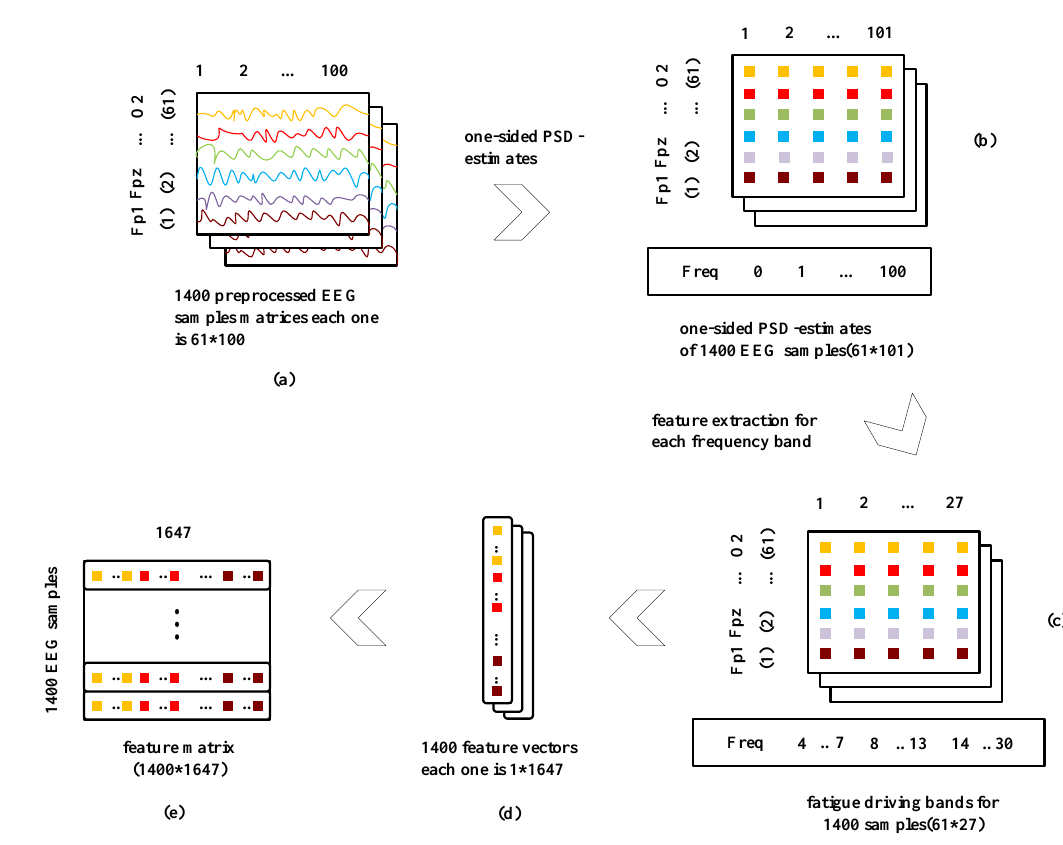
Figure 5. EEG feature vectors generation